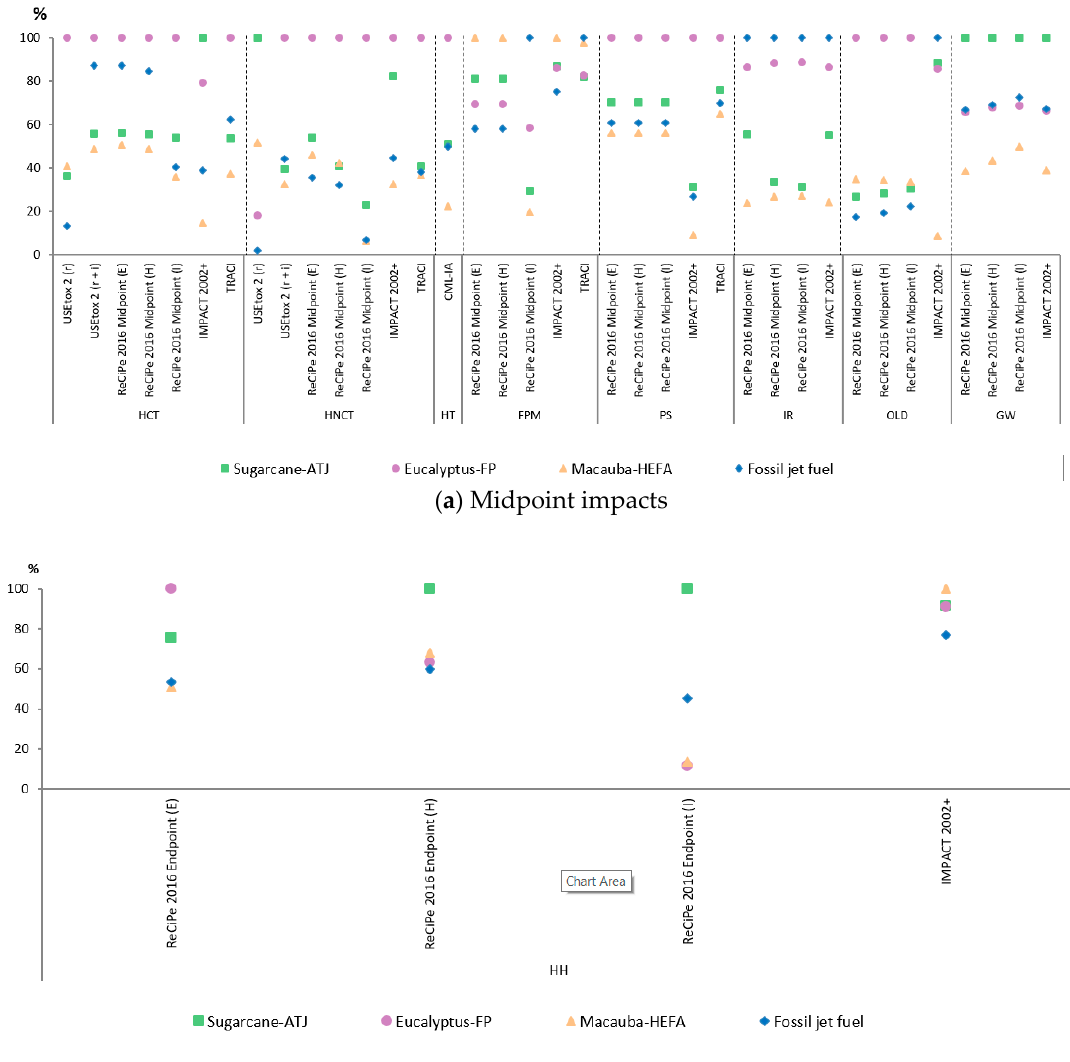
Figure 2. Life cycle midpoint ( a ) and endpoint ( b ) impacts of 1 L jet fuel, resulted from different LCIA methods (HCT: human carcinogenic toxicity, HNCT: human non-carcinogenic toxicity, FPM: fine particular matter, PS: Photochemical smog, IR: ionizing radiations, OLD: ozone layer depletion,